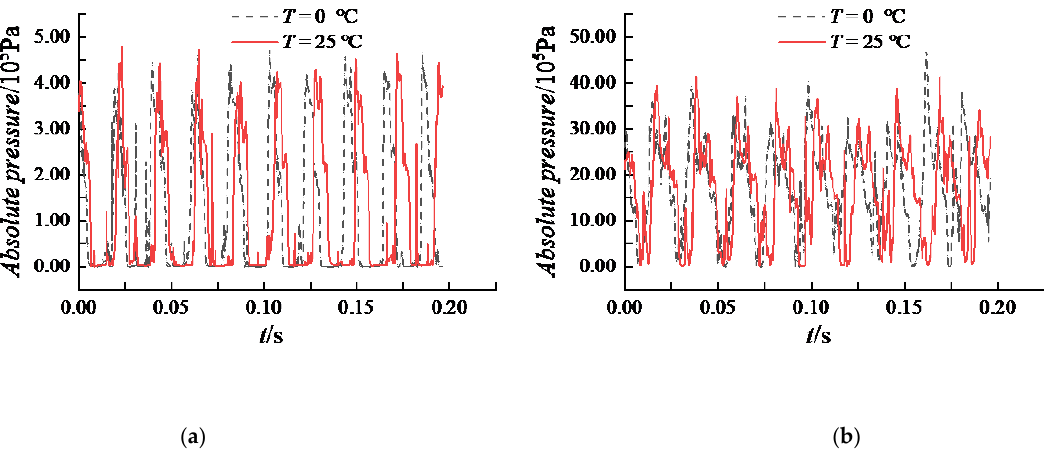
Figure 9. Comparison of natural cavitation pressure pulsation at points P1 ( a ) and P3 ( b ) at two temperatures.